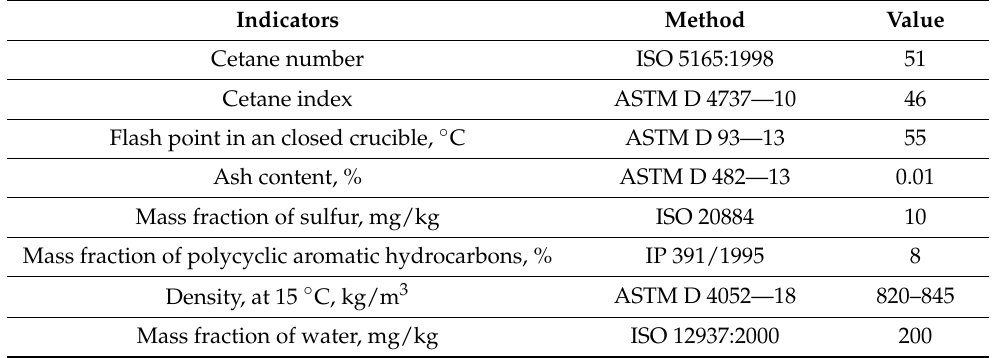
Table 4. Typical physicochemical characteristics of diesel fuel.